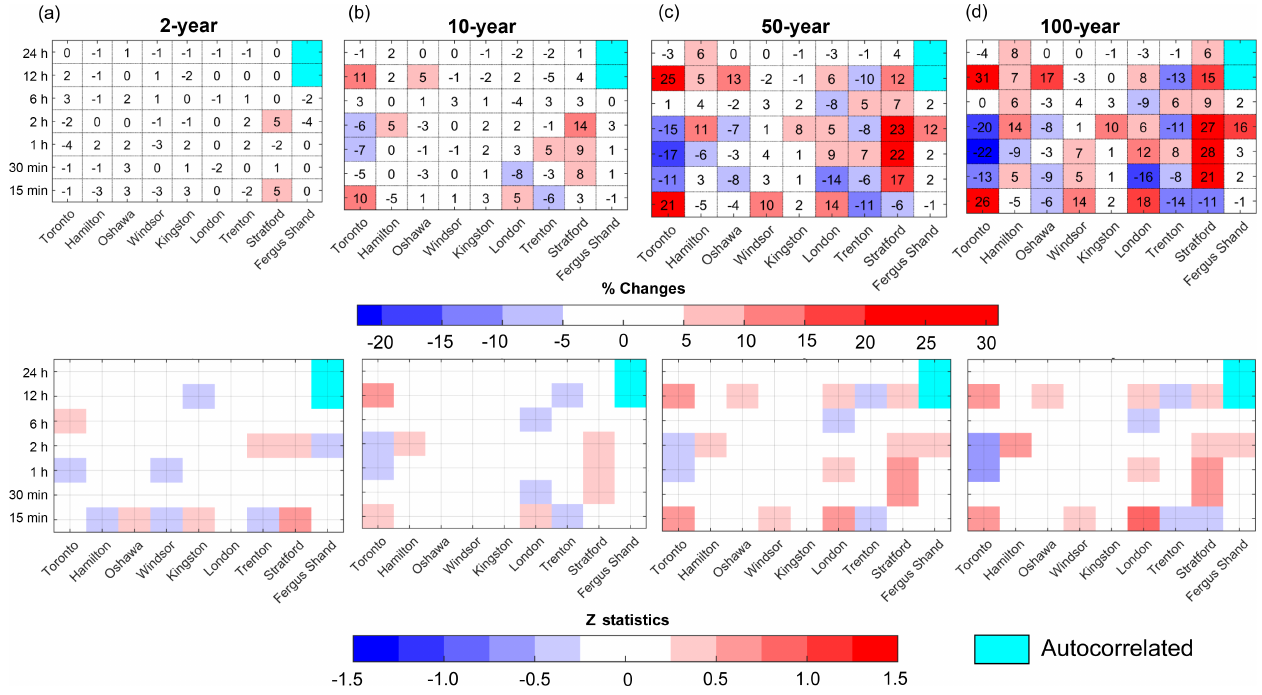
Figure 5. Percentage changes (top panel) and Z statistics (bottom panel) of at-site T -year event estimates for T = 2-year to T = 100-year return periods (a–d) with durations between 15min and 24h in nine urbanized locations, Southern Ontario. The Z statistic represents the statistical significance of differences in DSI obtained from the best selected nonstationary vs. stationary model. The Z statistic is statistically significant when | Z | > 1 . 64 at the 10% significance level. The shades in blue and red denote decrease and increase in Z statistics, with the strength of the shading representing the magnitude of the test statistics. The durations with significant autocorrelations are excluded from the